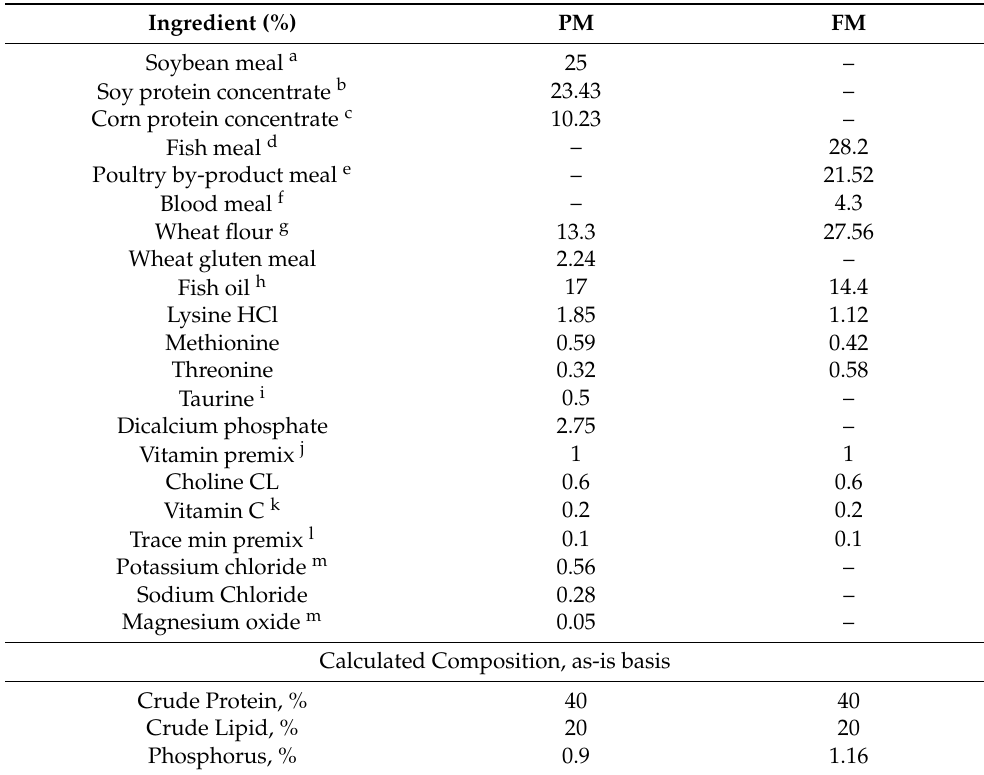
Table 3. Dietary composition and proximate analysis of the two diets administered. Values listed as mean (from technical